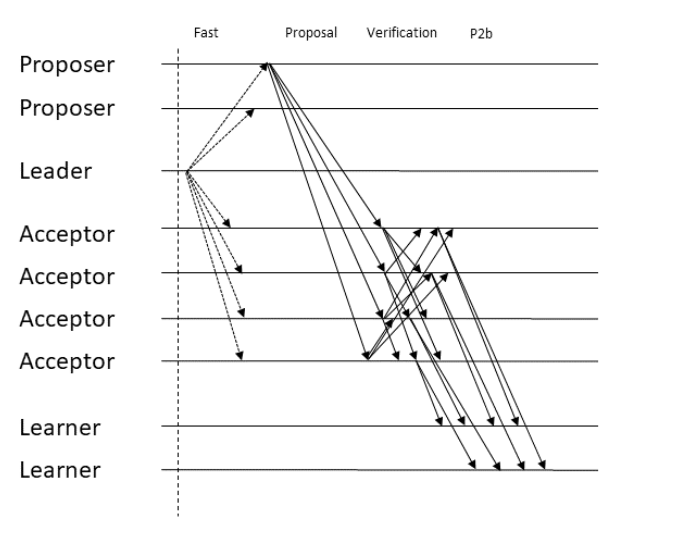
Figure 1. BGP’s fast ballot message